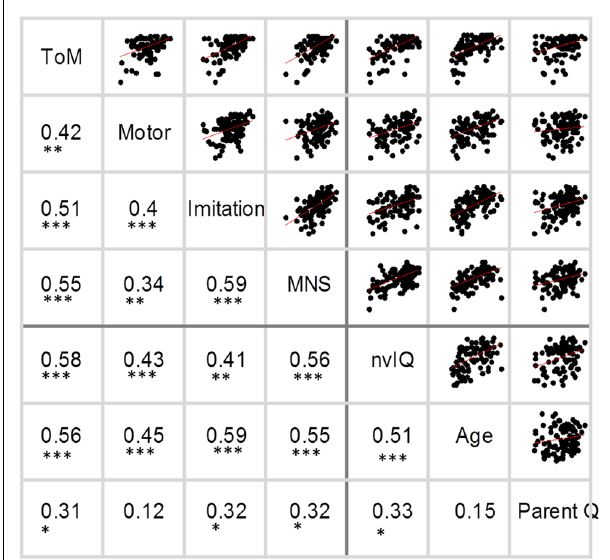
FIGURE 1 | Correlations between all variables. In the upper triangle, each dot represents one participant and the line-of-best-fit is shown in red. In the lower triangle, values are Pearson’s r . ∗ indicates correlations meeting the p < 0.002. Bonferroni corrected threshold. ∗∗ indicates correlations at p < 0.00001. ∗∗∗ indicates correlations at p < 0.0000001.